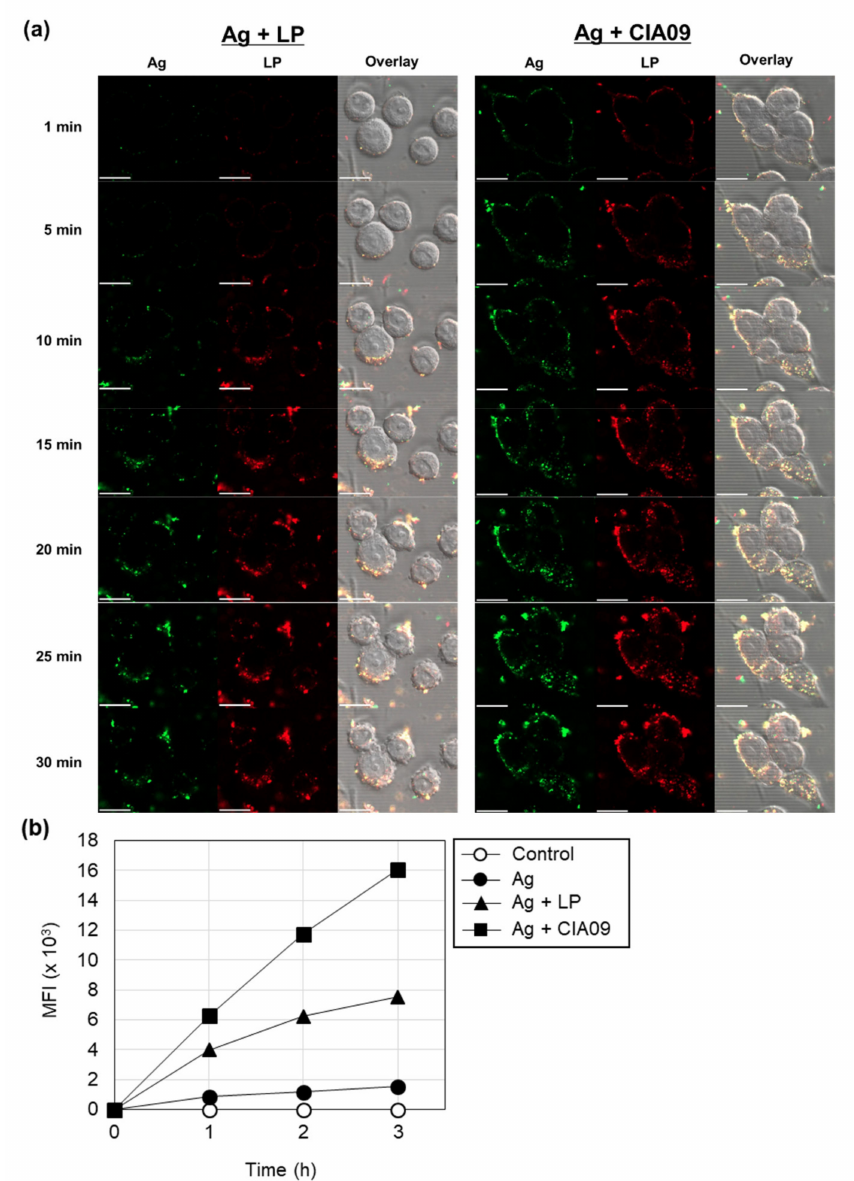
Figure 5. Cooperative effects of liposomes (LP) and dLOS on the cellular uptake of gE antigen. ( a ) DC2.4 cells were treated with AF488-labeled gE antigen (green) in combination with DiR-labeled liposomes (red) or CIA09 and cultured at 37 ◦ C. Cumulative cellular fluorescence was acquired over 30 min using a laser scanning confocal microscope. The data presented are representative of two experiments with similar results. Scale bar = 20 µ m. ( b ) DC2.4 cells were treated with AF647-labeled gE antigen, alone or in combination with dLOS (1 µ g/mL), liposomes (50 µ g/mL), or both, and cultured at 37 ◦ C for 1, 2, or 3 h followed by flow cytometry. The data presented are representative of three independent experiments with similar